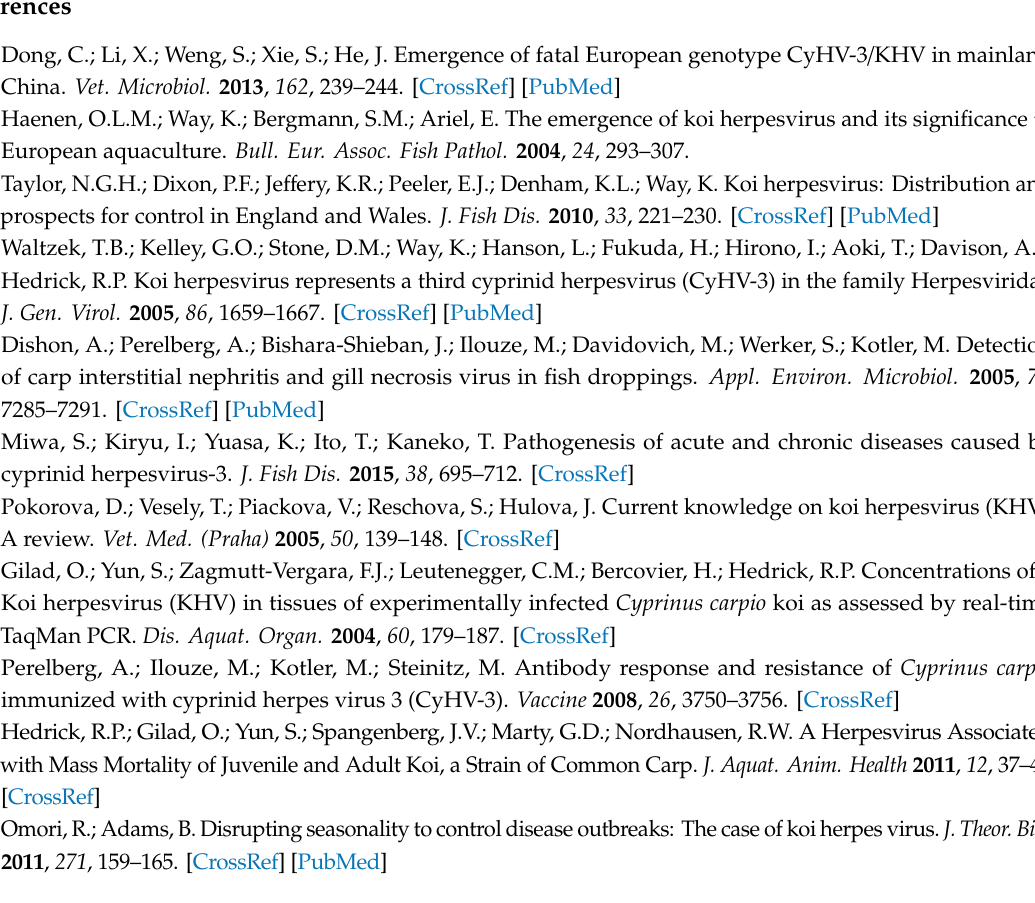
Figure S1: Example of common carp skin swabbing procedure; Figure S2: Taqman qPCR efficiency curves. Positive cDNA dilutions 1:10. 1:100 and 1:1000; Figure S3. Relative gene expression over time in common carp skin swabs exposed to koi herpesvirus